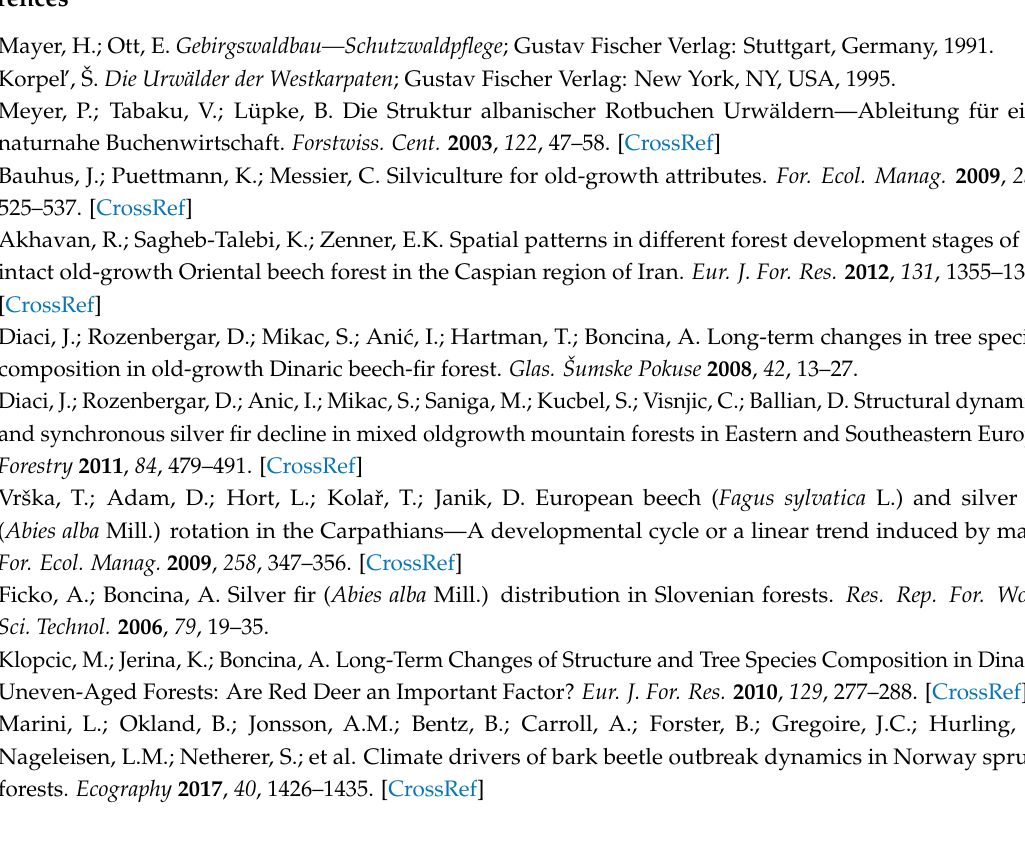
Figure A1. Frequency of canopy gaps and canopy gaps with regeneration cover according to gap size.